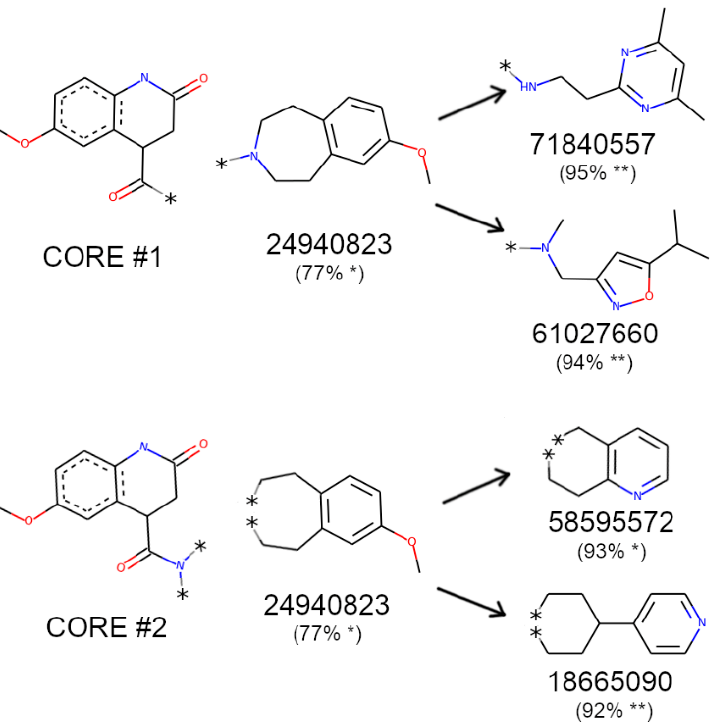
Figure 19. R-group decomposition for the most active compounds found among in silico candidates with activities (% remaining hRIPK1 activity) portrayed in parenthesis. * tested at 5 µ M concentration; ** tested at 30 µ M concentration.